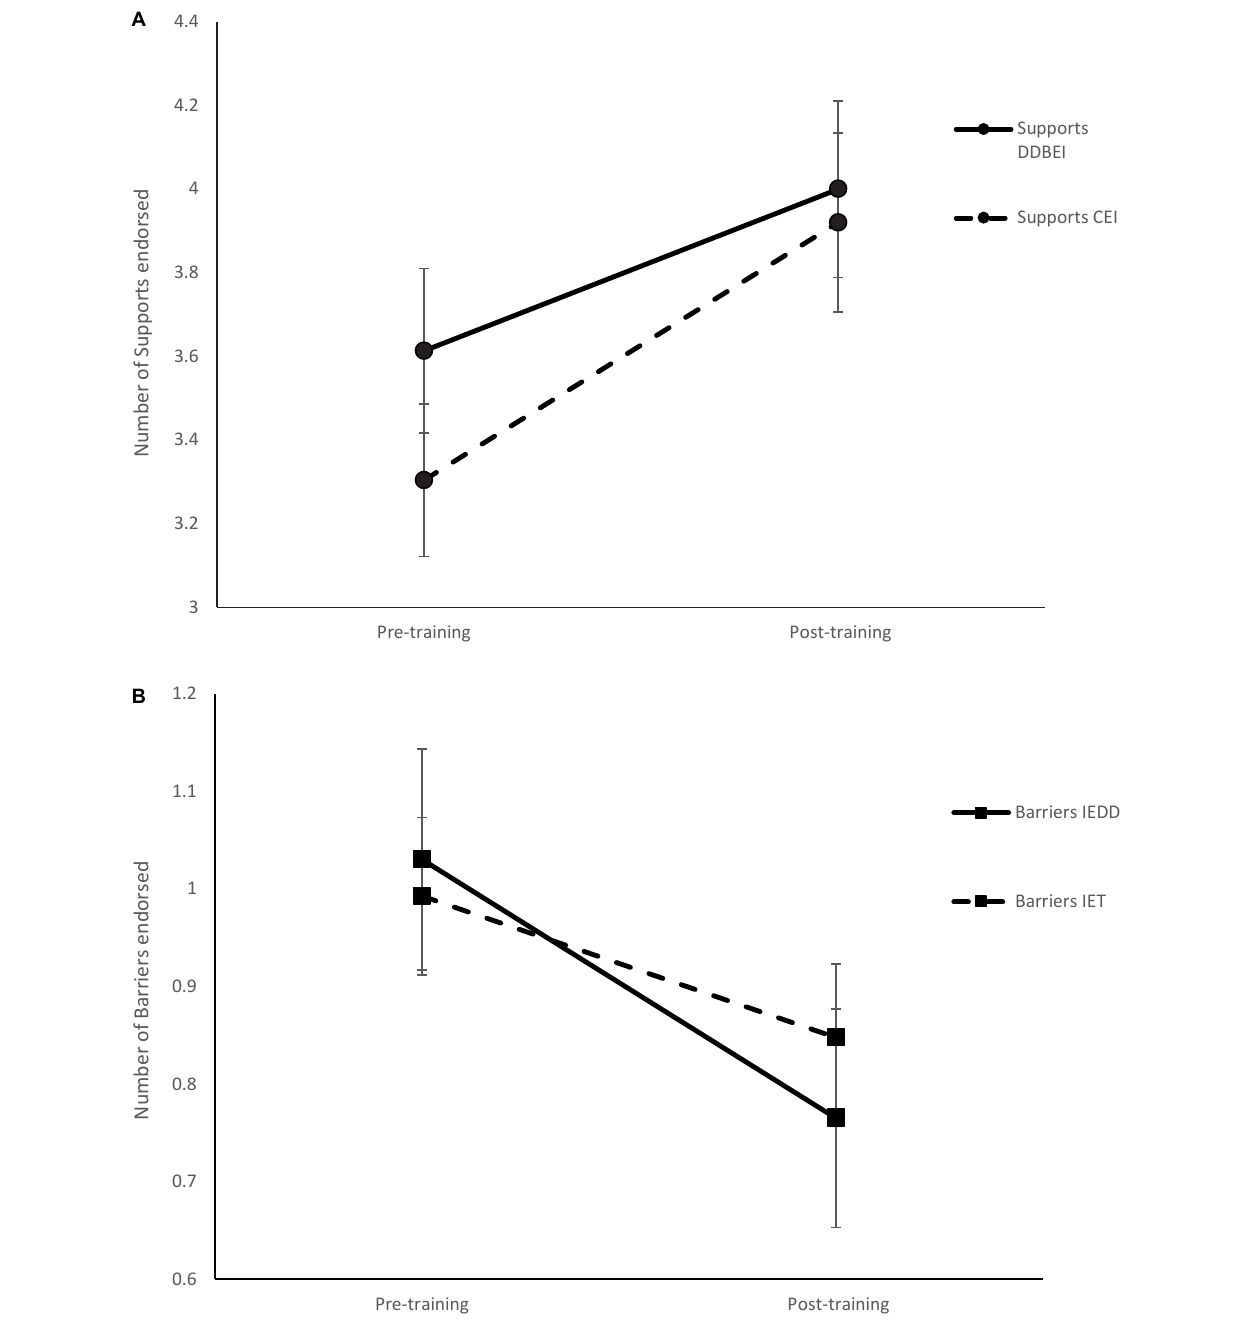
FIGURE 3 | Change in the number of Supports (A) and Barriers (B) for hearing-protective behavior before and after training with the Dangerous Decibels (DDBEI) and Conventional (CEI) training methods. Error bars represent one standard error of the